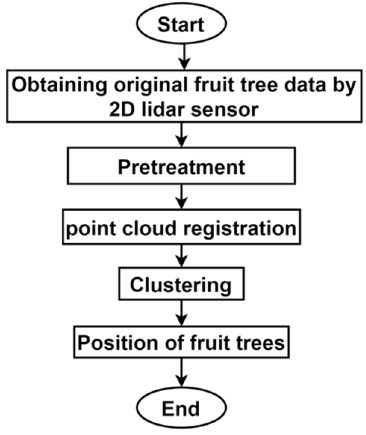
Figure 2. The process of fruit tree perception.